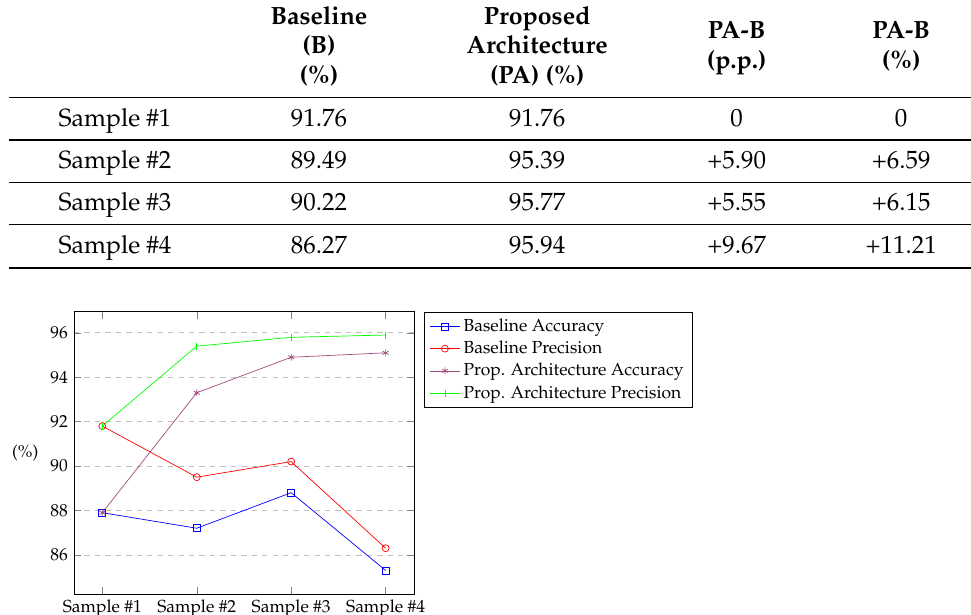
Table 8. Precision results of baseline and proposed architecture scenarios.